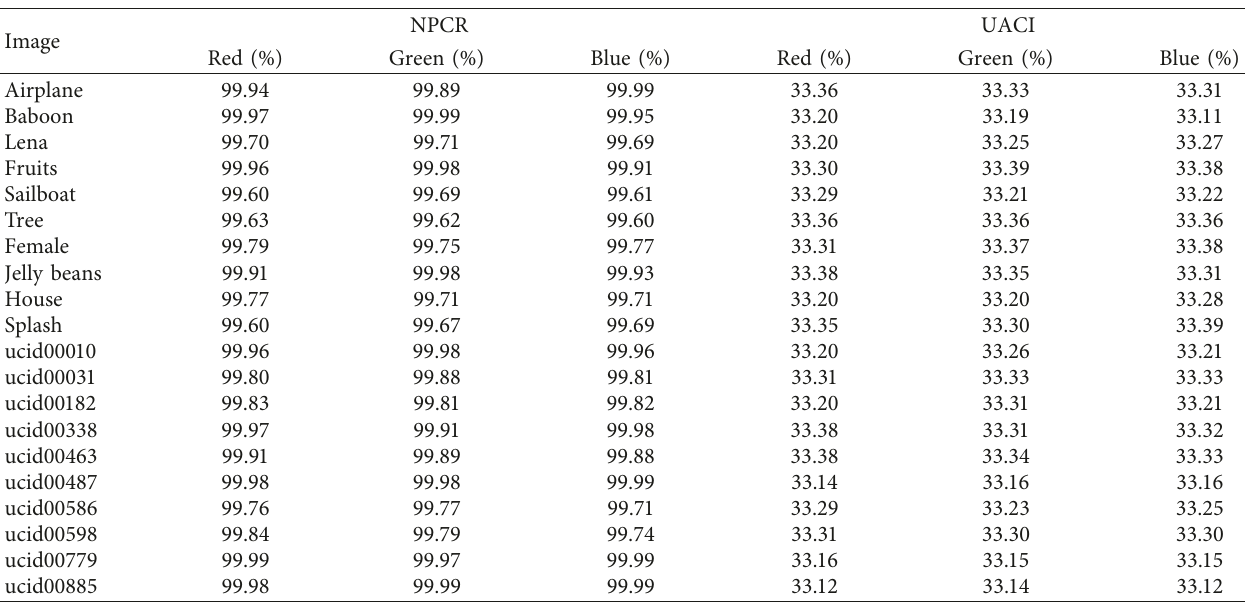
Table 8: NPCR and UACI results.